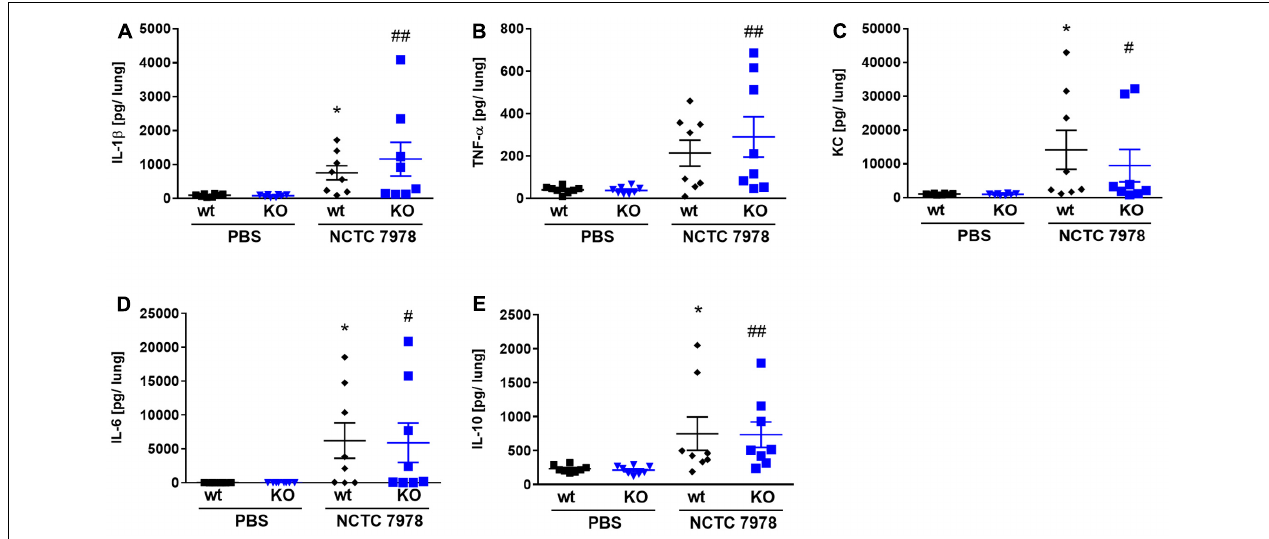
FIGURE 3 | Cytokine response in the lung of wt and PGLYRP3KO mice. The S. pneumoniae -dependent cytokine response was analyzed 48 h post infection with 10 5 CFUs of wt pneumococcal strain NCTC 7978 per mouse in lung homogenates. The production of IL-1 β (A) , TNF- α (B) , KC (C) , IL-6 (D) , and IL-10 (E) was quantified by ELISA. Eight animals per group (mean ± SEM); Kruskal–Wallis with Dunn’s multiple comparison test was used for statistics. Significant differences in the cytokine response between uninfected and infected wt lungs were indicated as ∗ p < 0.05 and the cytokine response in uninfected vs. infected PGLYRP3KO lungs as # p < 0.05; ## p <